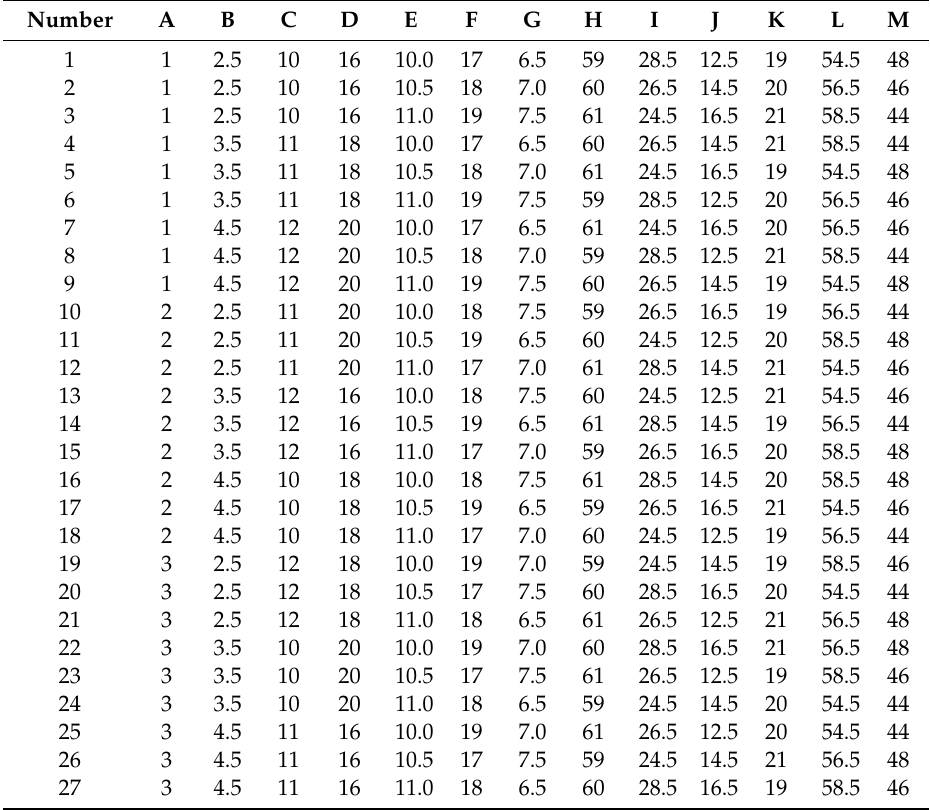
Table 3. Orthogonal experimental design scheme of FEV air-cooling heat-dissipation